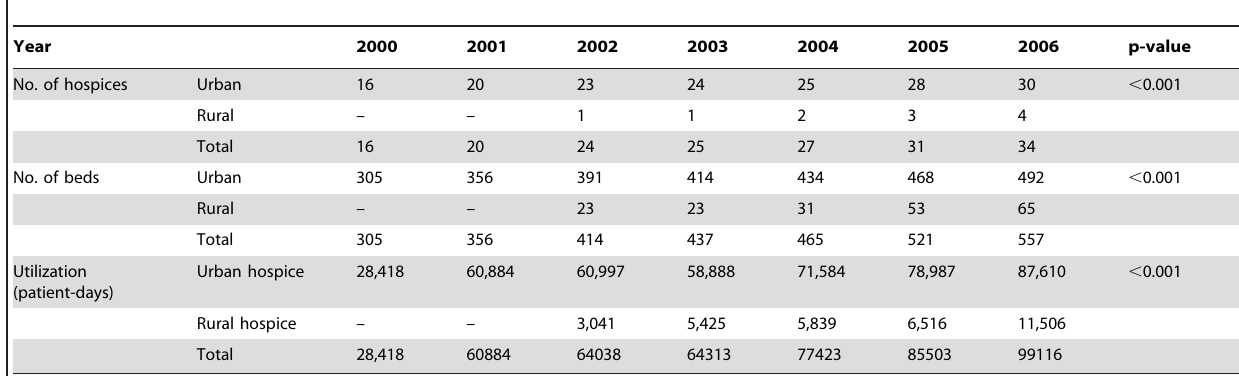
Table 2. Hospice resources and utilization from